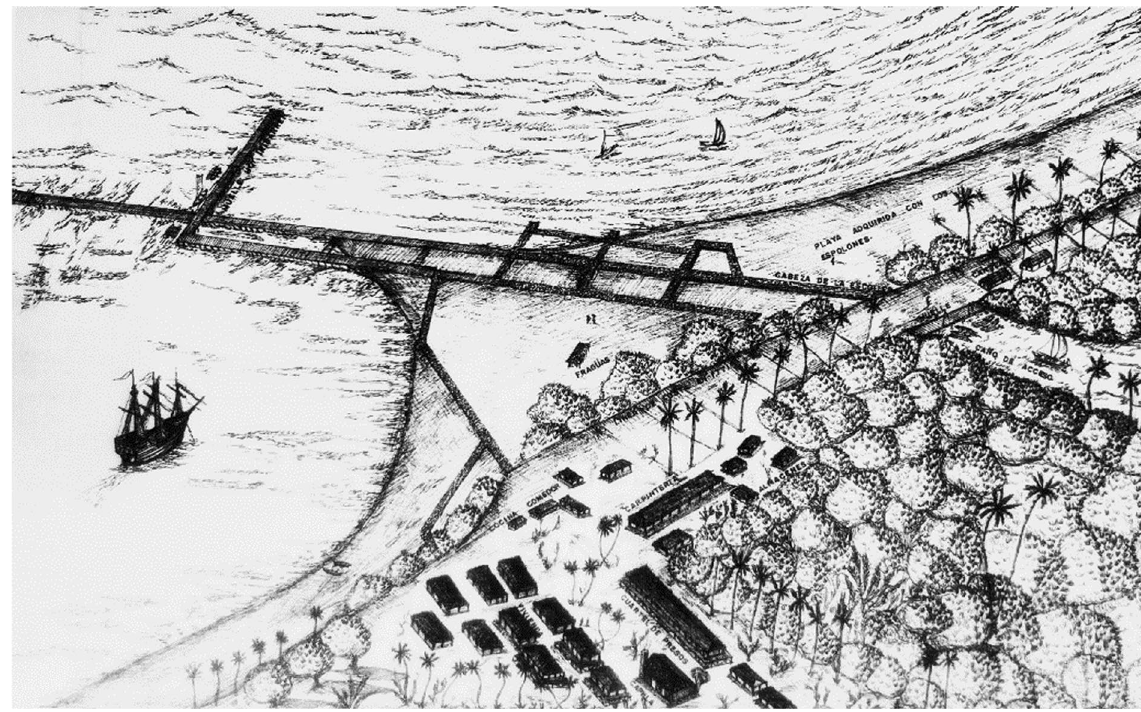
Fig. 4 Camp for the works of the Bocagrande breakwater. Draft taken and adapted from (Cabrera Cruz et al.